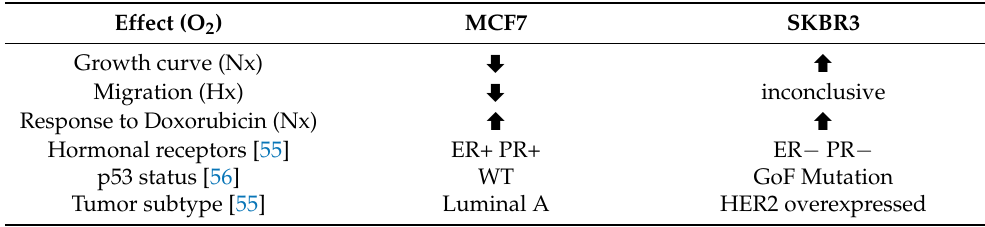
Table 2. Effect of MB expression in MCF7 and SKBR3 cells as compared to MB-KO cells.